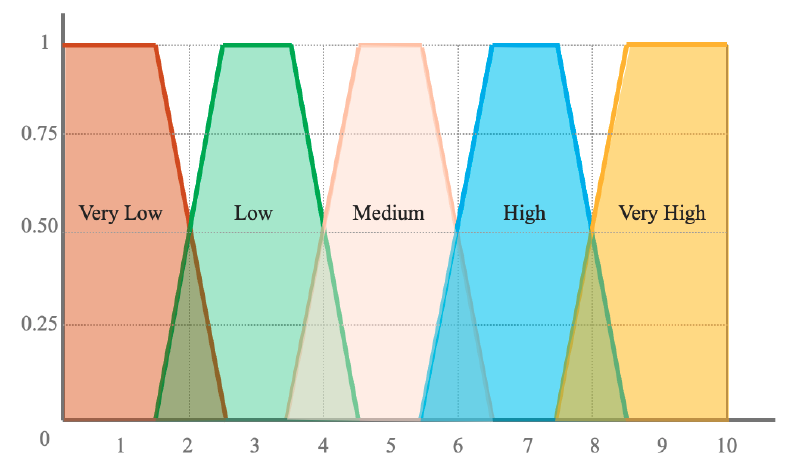
Figure 3. Definition of fuzzy risk